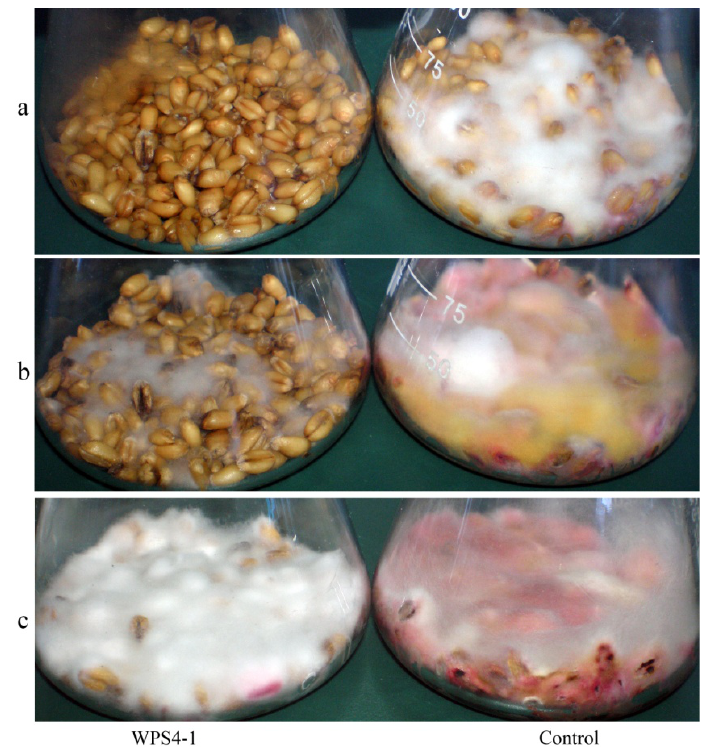
Figure 2. The mycelia growth of F. graminearum in wheat kernels with bacterial cell-free culture supernatant (strain WPS4-1) and deionized water (control) added. ( a ) four days of culture, ( b ) ten days of culture and ( c ) eighteen days of